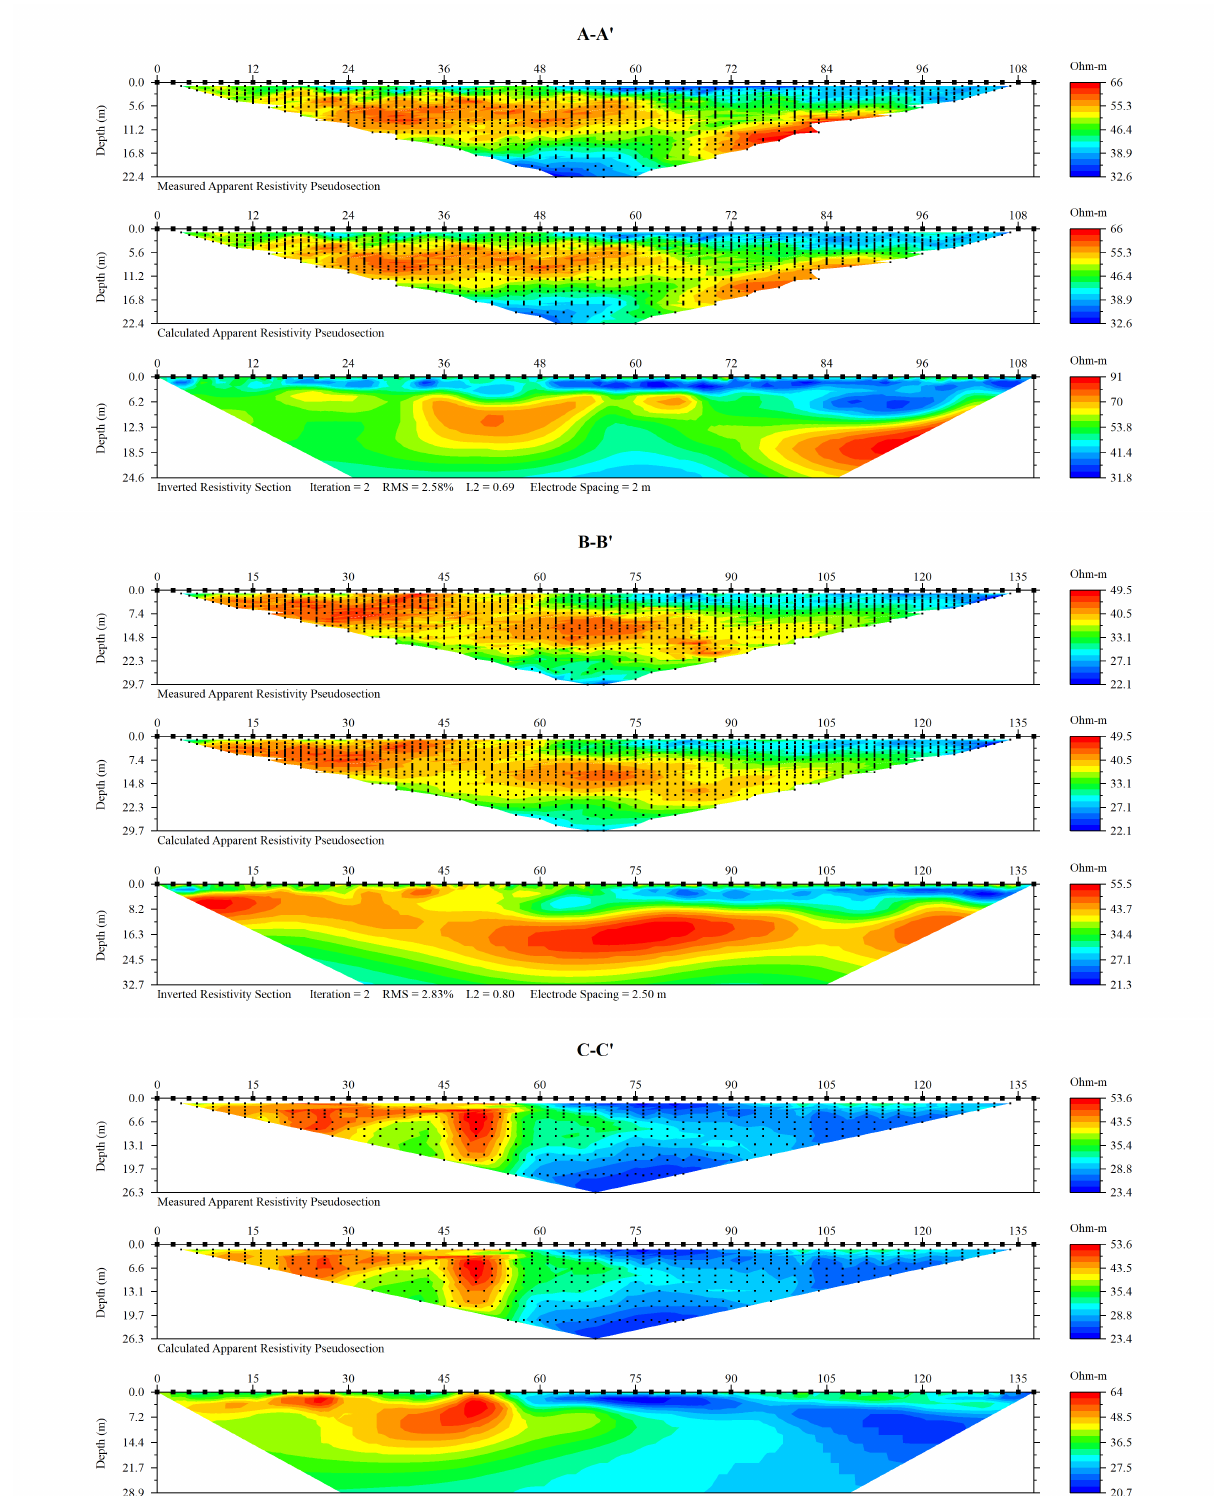
Figure A1. Top panel : apparent resistivity field data. Middle panel : calculated apparent resistivity. Bottom panel : inverted electrical resistivity. Black dots are the position of measured and calculated apparent resistivity data. RMS misfit is less than three percent for all data. Note that the individual profiles are not on a common color